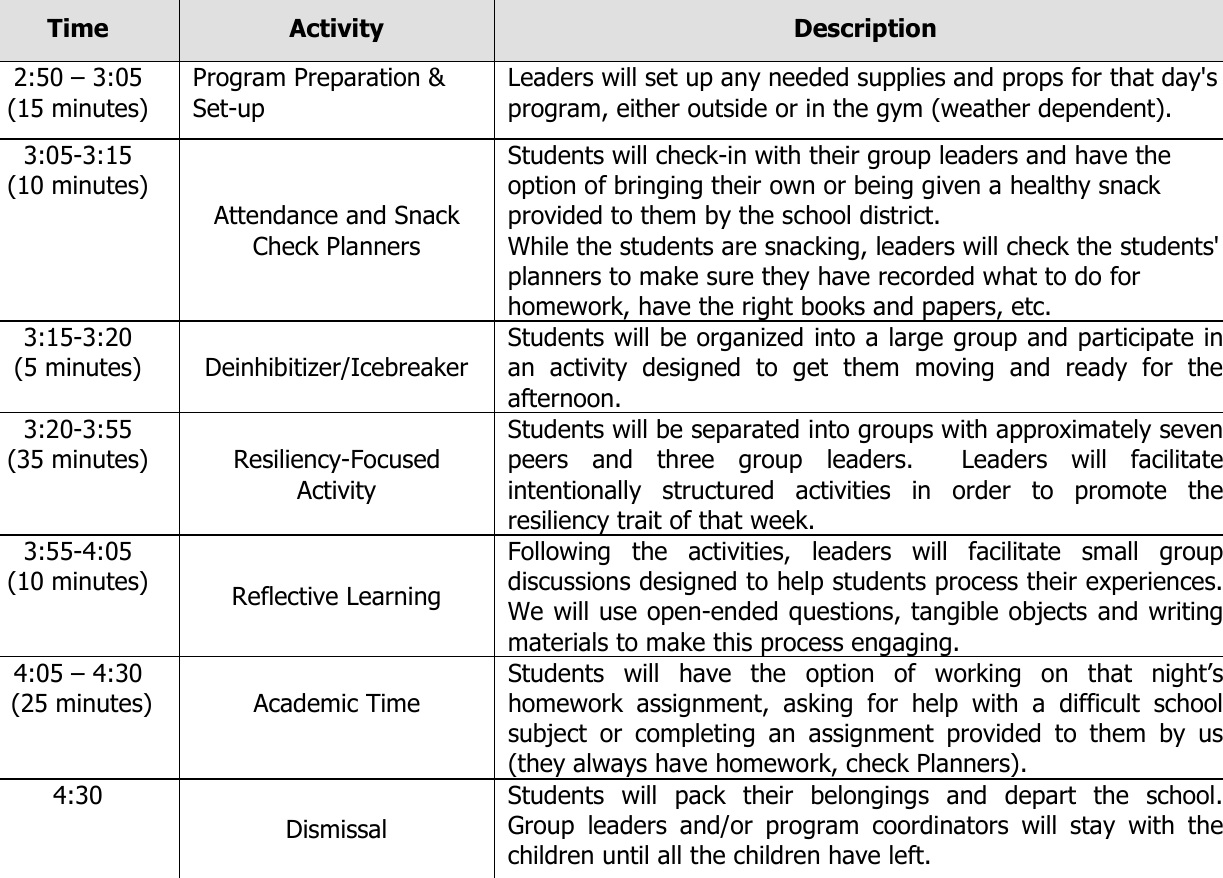
Example Program